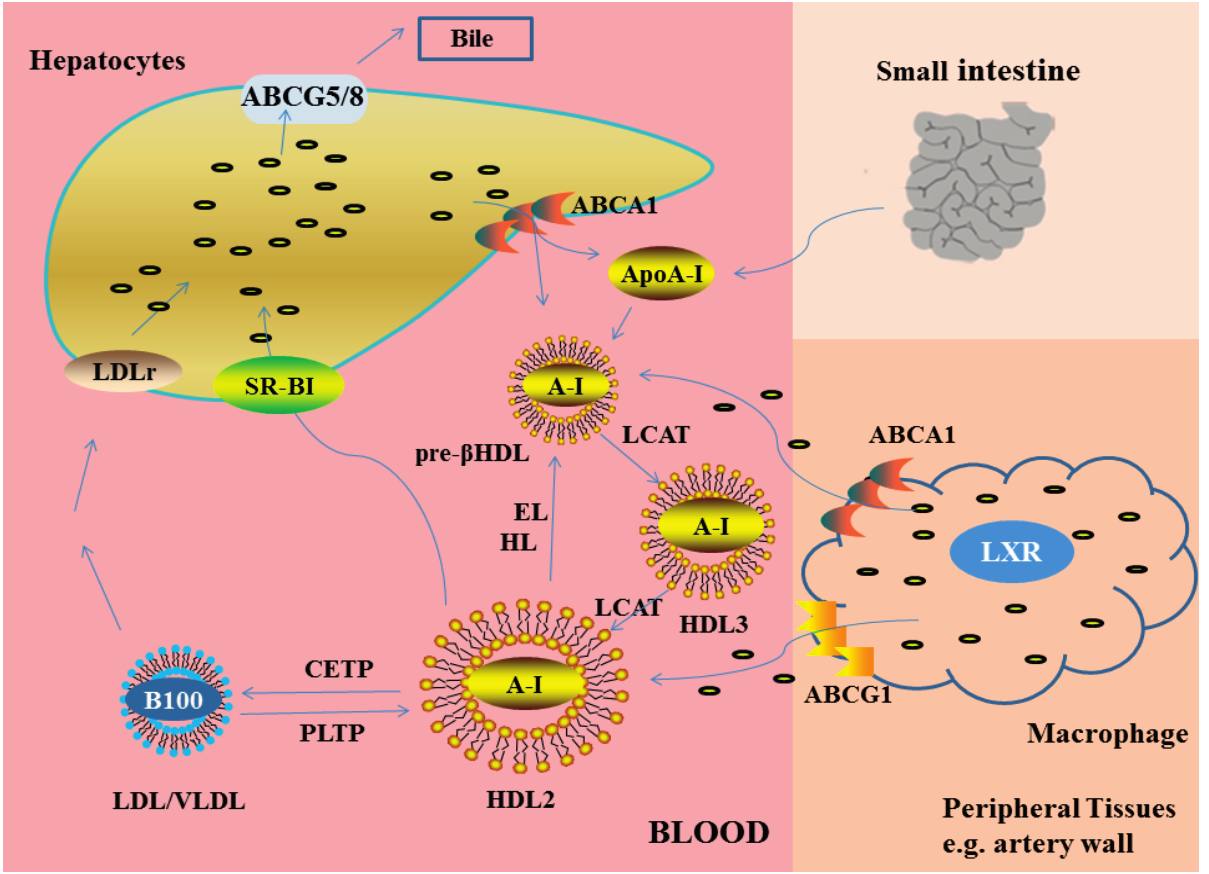
Figure 2. HDL in reverse cholesterol transport pathway. Lipid-poor apoA-I also promotes the efflux of free cholesterol from macrophages via ABCA1. LCAT esterifies free cholesterol to cholesteryl esters to form mature HDL, which promotes cholesterol efflux from macrophages via the ABCG1 transporter, as well as from other peripheral tissues by processes not fully defined. In macrophages, both ABCA1 and ABCG1 are regulated by Liver X receptors (LXR). Mature HDL can transfer its cholesterol to the liver directly via scavenger receptor class B type I (SR-BI) or indirectly via CETP-mediated transfer to ApoB-containing lipoproteins, with subsequent uptake by the liver via the LDL-r. Hepatic cholesterol can be excreted directly into the bile as cholesterol or after conversion to bile acids and, unless reabsorbed by the intestine, is ultimately excreted in the feces. HL, EL, and PLTP, play an indispensable role in remodeling HDL, thus, the RCT pathway is dependent on interaction with them